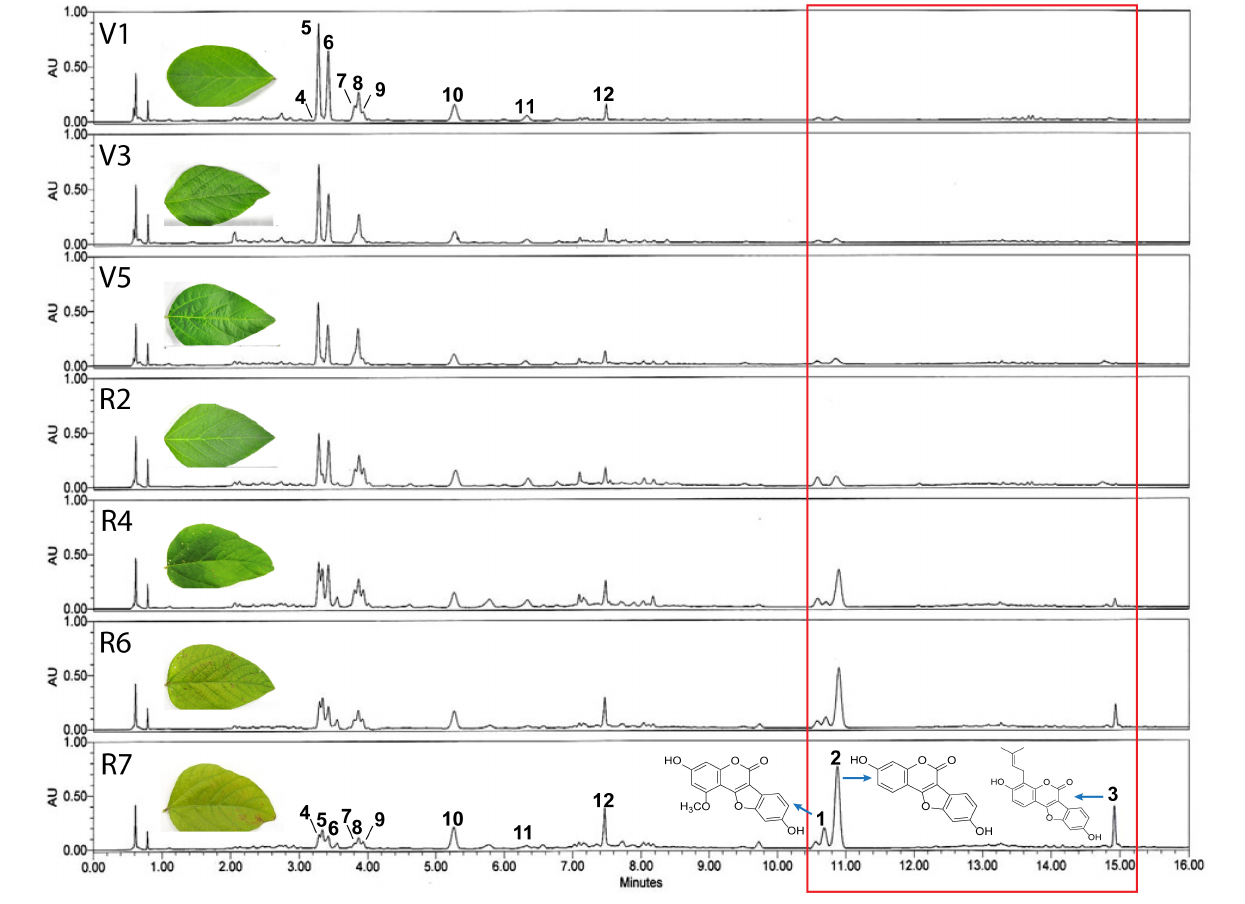
FIGURE 1 | Representative UPLC-PDA ( λ max ) chromatograms. Representative chromatograms of compounds detected in soybean leaf extracts at different growth stages (vegetative: V1, V3, V5, and reproductive R4, R6, and R7). Results showed significant differences in the chemical composition of the leaves at various growth stages, as reflected by detecting diverse chemical compounds in the leaves collected at various growth stages. Eight chemical compounds (peaks 5–12) detected were found to have significantly higher accumulation in the fresh leaves (V1) compared with mature leaves (R7). Furthermore, three major chemical groups present were detected only in mature yellow leaves of the R7 growth stage (red box, peaks 1, 2, and